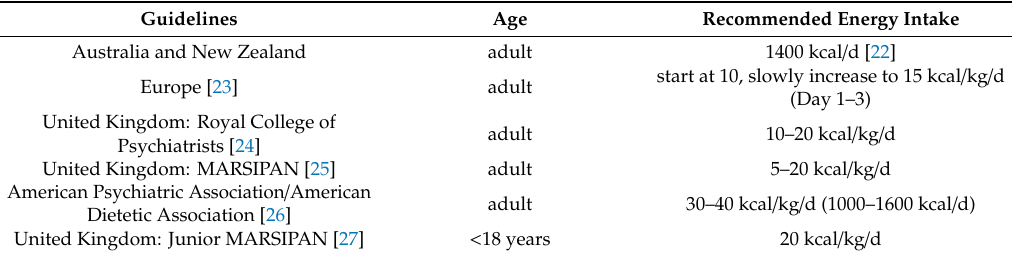
Table 3. Current, national refeeding guidelines for malnourished patients with anorexia